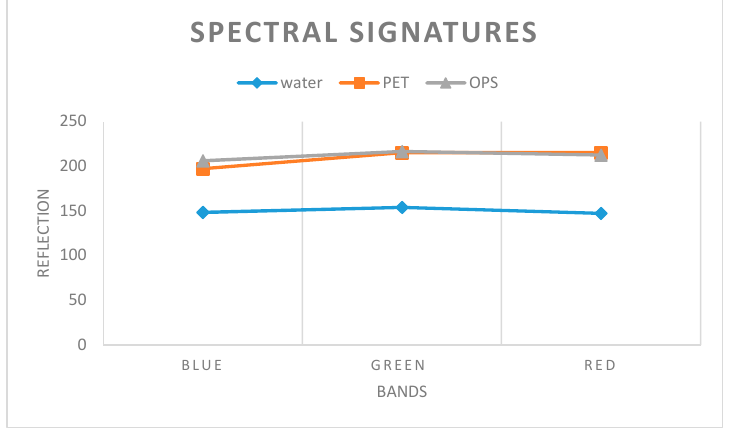
Figure 6. Spectral signatures of water, PET and OPS. Table 4. The e ff ect of spatial resolution (mm) on ResUNet50 performance (where P, R, F 1 are precision, recall, and F 1-score respectively) (Dataset